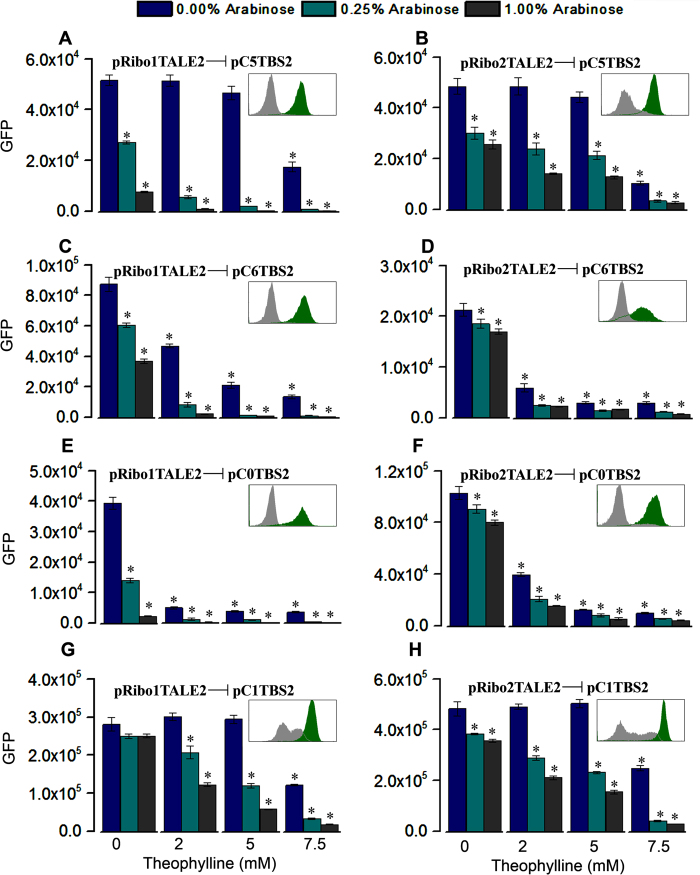
Repression of PConst-based target modules.Response of RiboTALE repression system that consists of (A) RiboTALE module pRibo1TALE2 and target module pC5TBS2, (B) RiboTALE module pRibo2TALE2 and target module pC5TBS2, (C) RiboTALE module pRibo1TALE2 and target module pC6TBS2, (D) RiboTALE module pRibo2TALE2 and target module pC6TBS2. (E) RiboTALE module pRibo1TALE2 and target module pC0TBS2, (F) RiboTALE module pRibo2TALE2 and target module pC0TBS2, (G) RiboTALE module pRibo1TALE2 and target module pC1TBS2, (H) RiboTALE module pRibo2TALE2 and target module pC1TBS2. Inset: flow cytometry results; green bar, GFP level at 0% arabinose and 0 mM theophylline; grey bar, GFP level at 1% arabinose and 7.5 mM theophylline; x-axis, GFP level; y-axis, count. Error bars represent standard error of the mean (N = 3). Significant differences between the unrepressed (0% arabinose and 0 mM theophylline) and repressed RiboTALE repression systems are indicated by * (p-value <0.05).